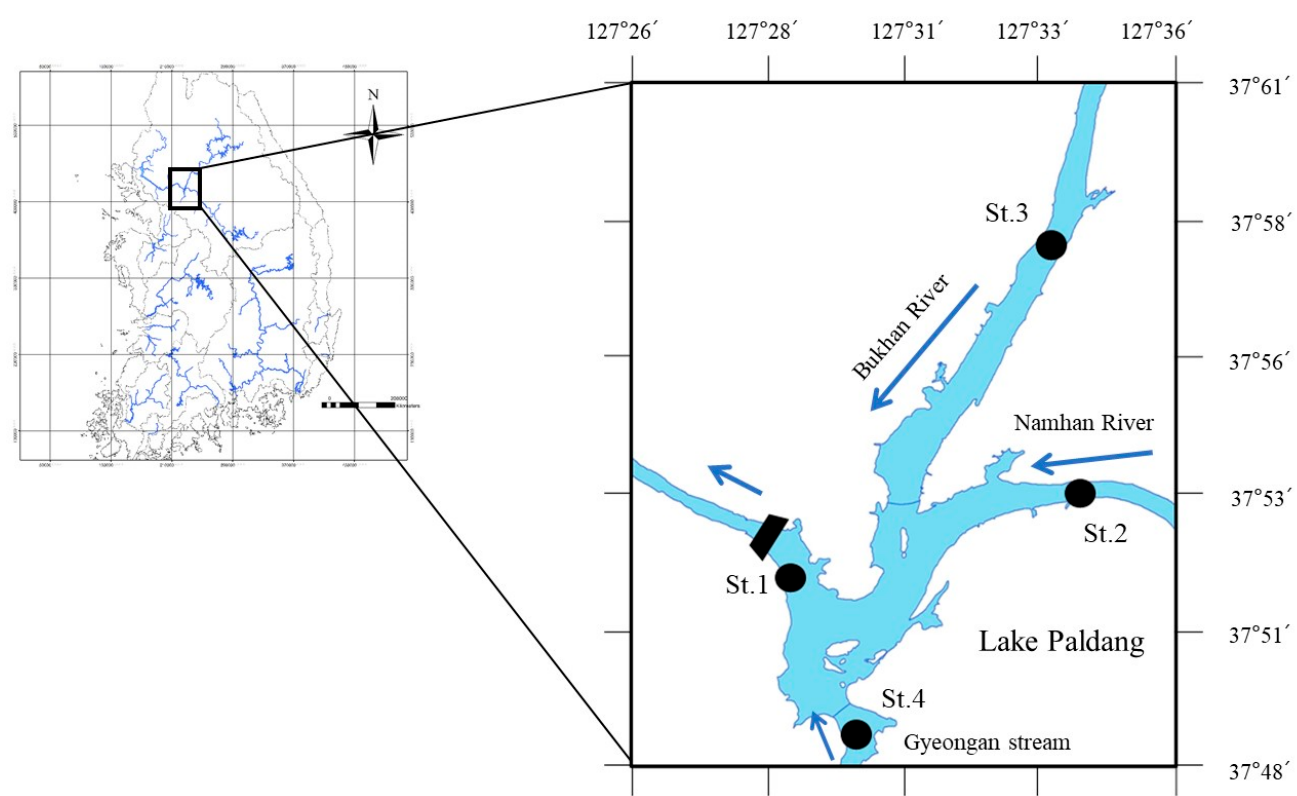
Figure 1. Map showing the location of Lake Paldang and the study sites including: St. 1, Lake Paldang; St. 2, Namhan River; St. 3, Bukhan River; and St. 4, Gyeongan stream.